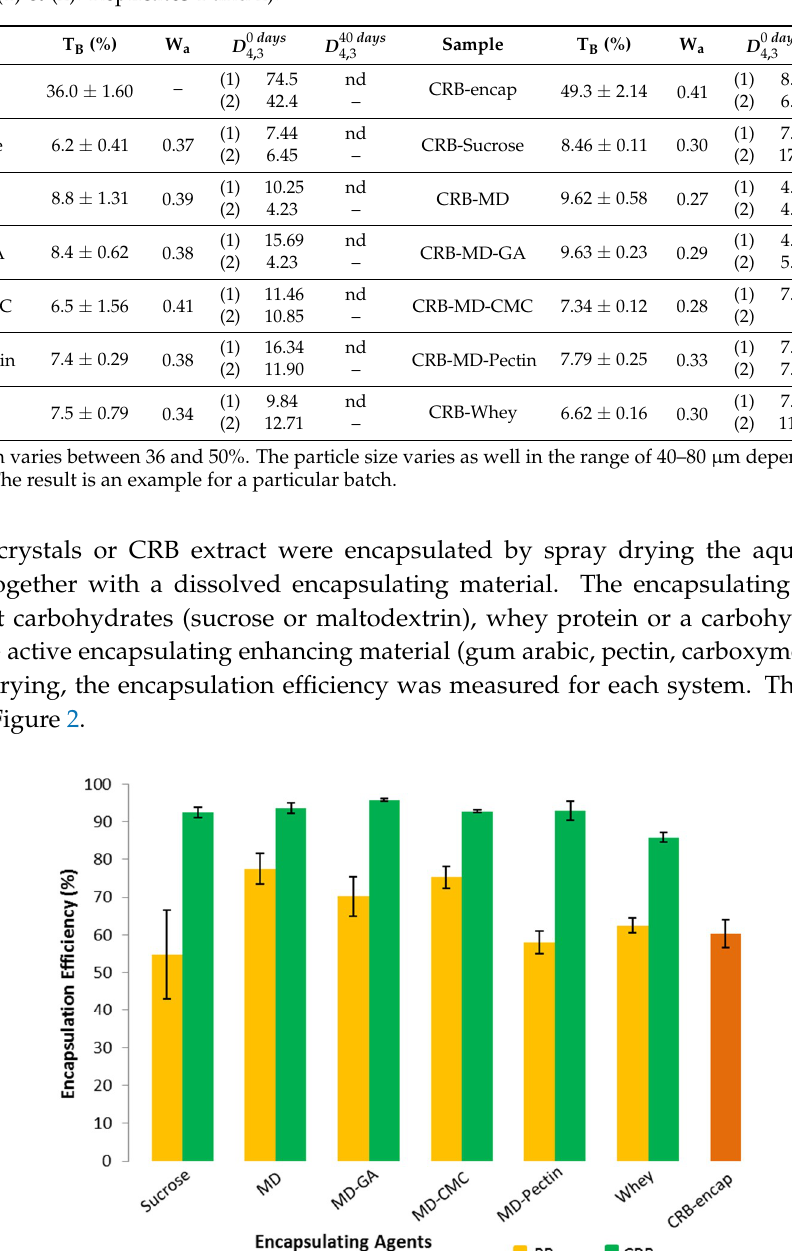
Table 2. Total bixin (T B ) contents and water activity (W a ) of spray dried powders, volume weighted